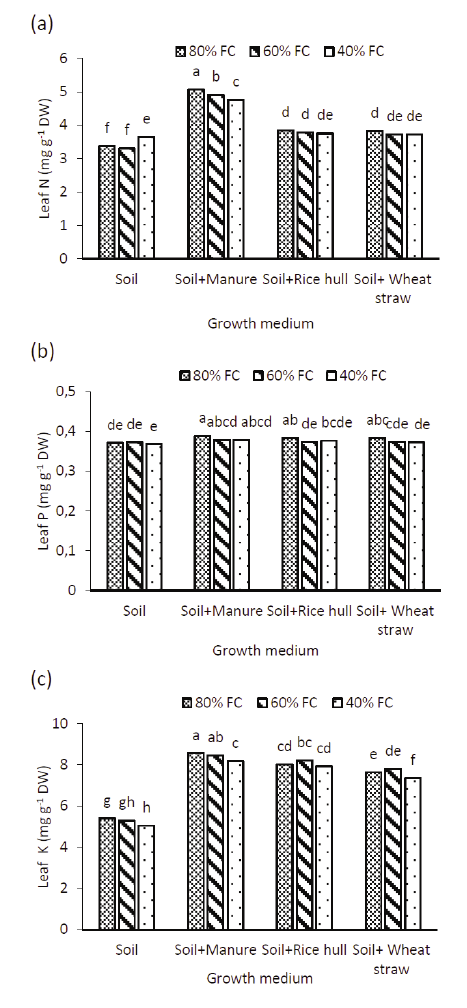
Fig. 1 ­ Leaf N (a), leaf P (b), and leaf K (c) of hollyhock plants. Values in columns followed by the same letter are not significantly different at the 0.05 level